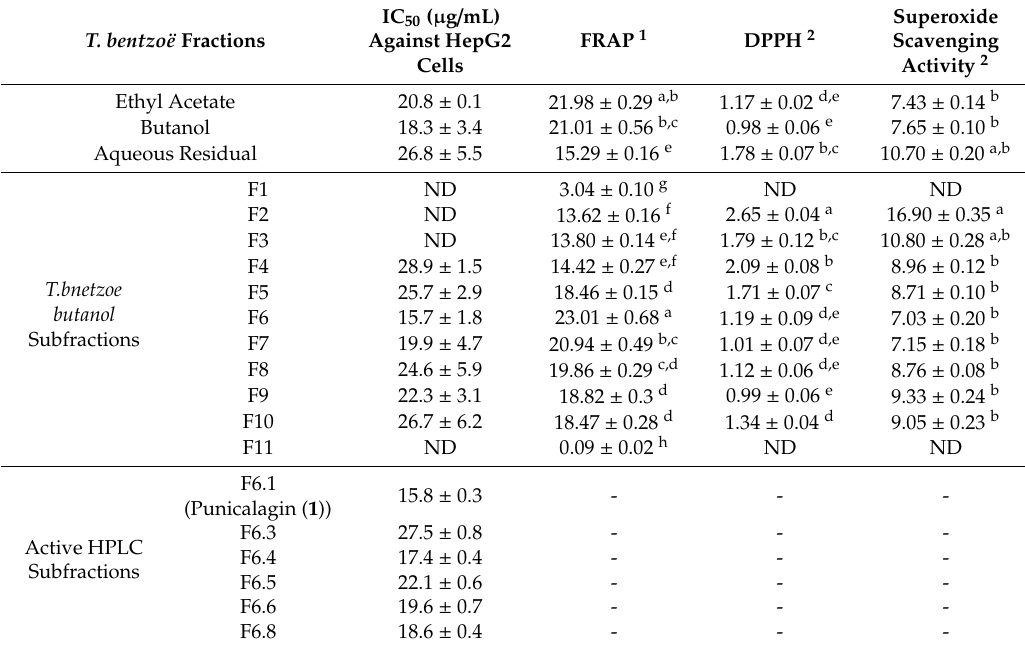
with a standard error of the mean ( n = 3). Di ff erent letters between rows in each column represent significant di ff erences between extracts ( p < 0.05). Letter “a” represent the most potent antioxidant activity, while letter “g” represent the least potent activity. ND = IC 50 value not reached at maximum test dose. “-“ = Not tested.